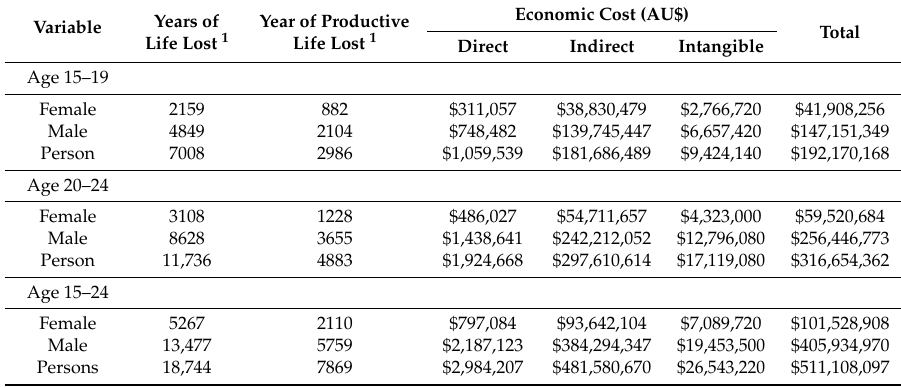
Table 4. The total economic cost of youth suicide, Australia, 2014, by age and sex.